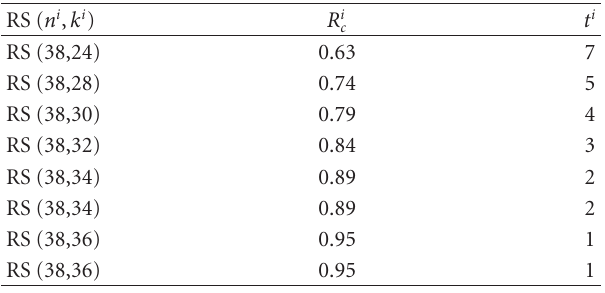
Table 3: Actual parameters for Reed-Solomon UEP coding at P b = 10 − 3 for u 2 ( τ ) transmission.